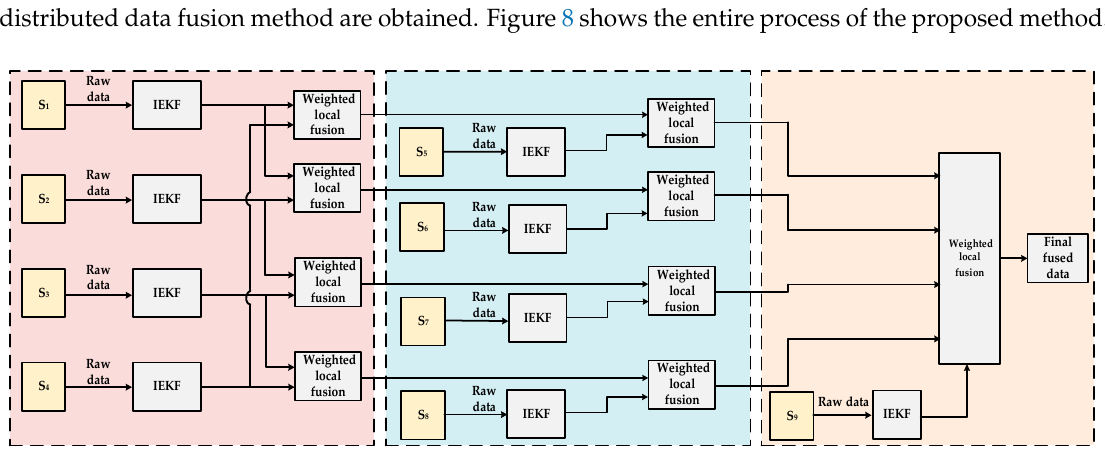
Figure 8. Distributed multi-sensor data fusion.